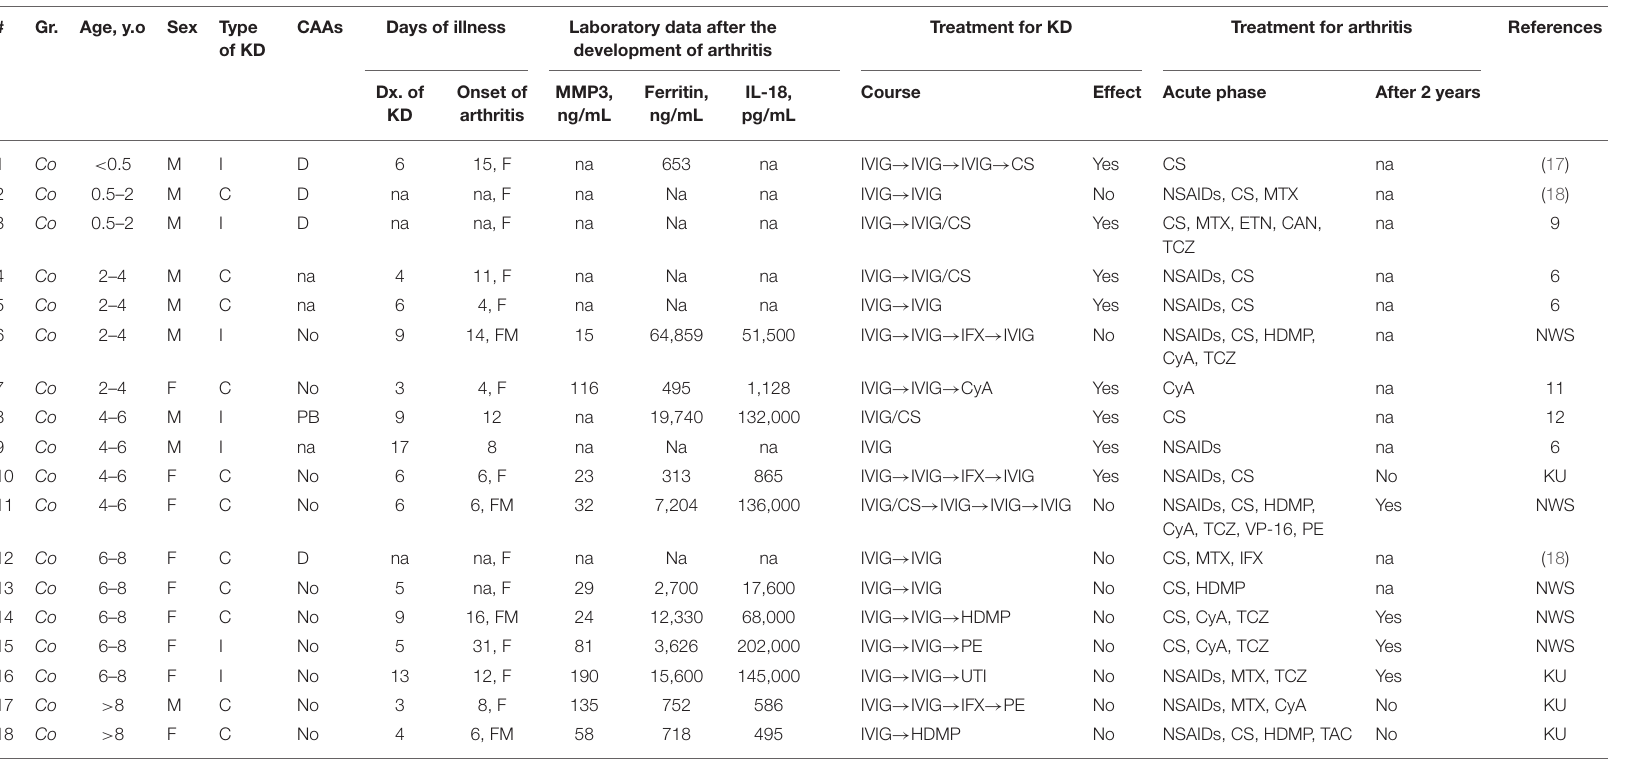
TABLE 2 | Detailed information of the continued fever-onset ( Co. )